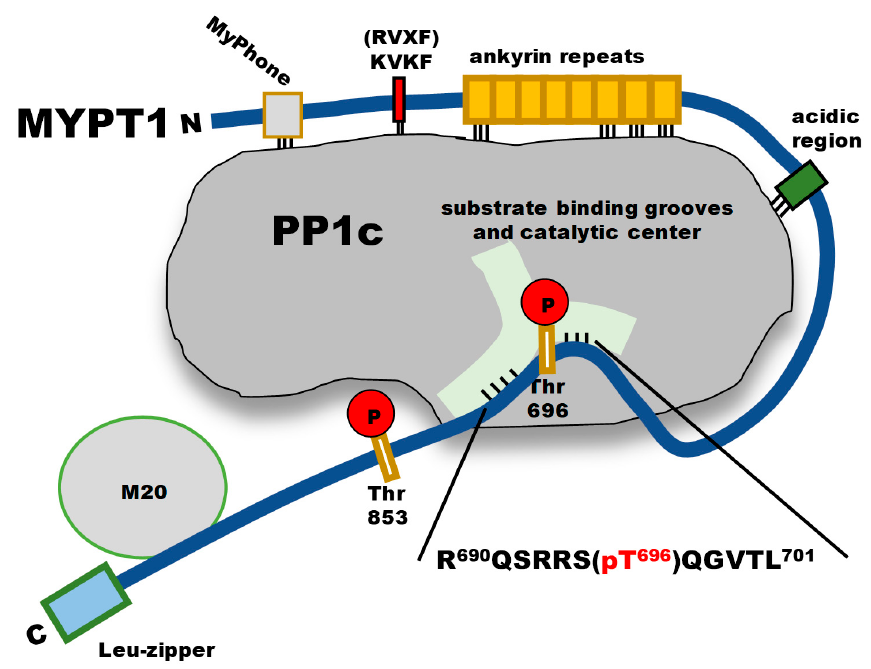
Figure 1. The structure of myosin phosphatase holoenzyme depicting interactions between PP1c, phosphorylated MYPT1 and M20 subunits.